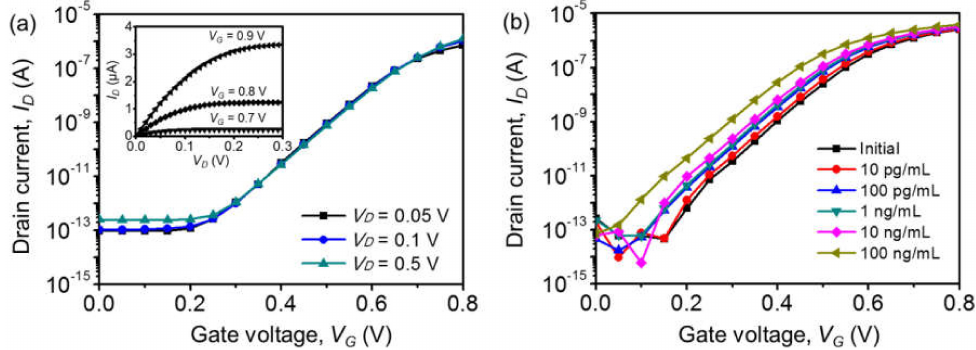
Figure 4. ( a ) Log-scaled I D - V G transfer characteristics of the fabricated Si-EGT for various V D . Inset: I D - V D output characteristics. ( b ) Log-scaled I D - V G for varying [PA]s of 10 pg/mL to 100 ng/mL.